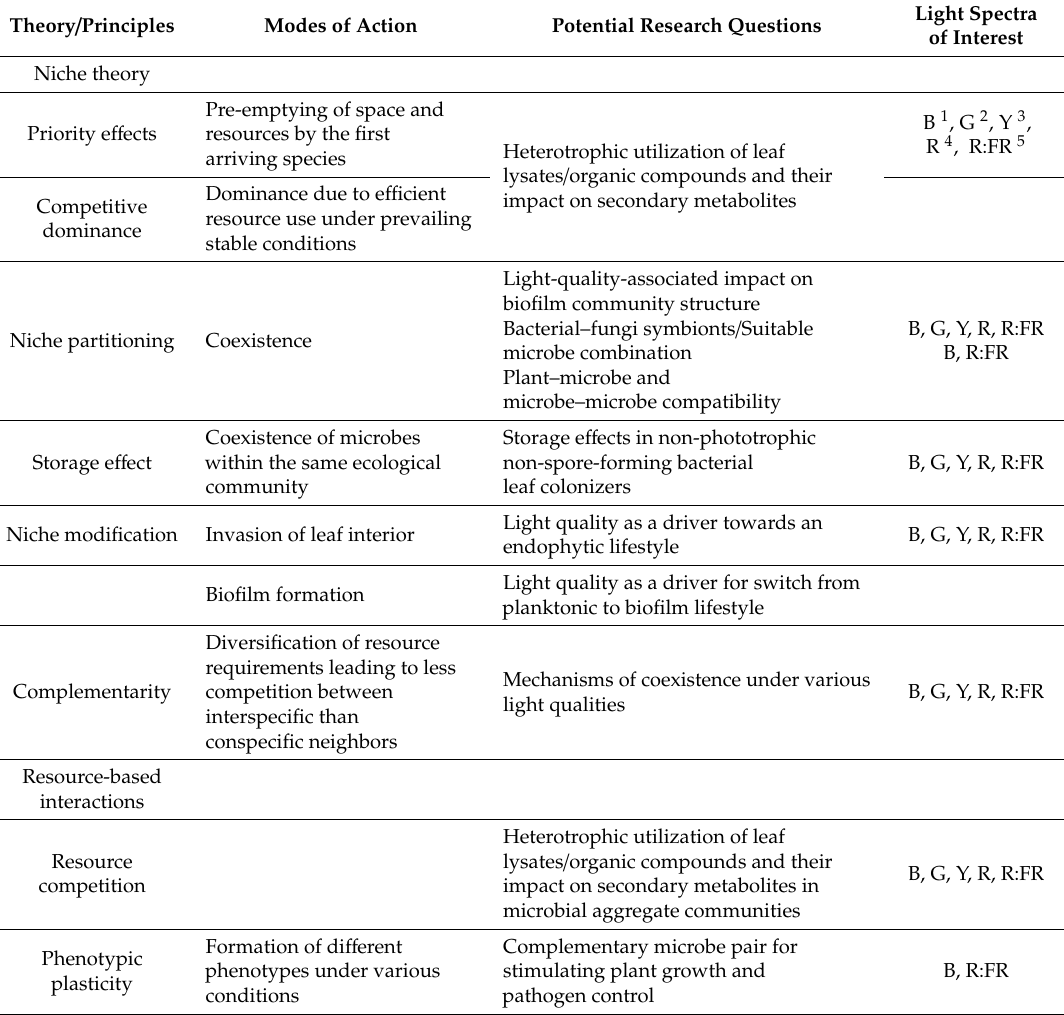
Table 3. Ecological theories and principles of interest to use in light-assisted phyllosphere